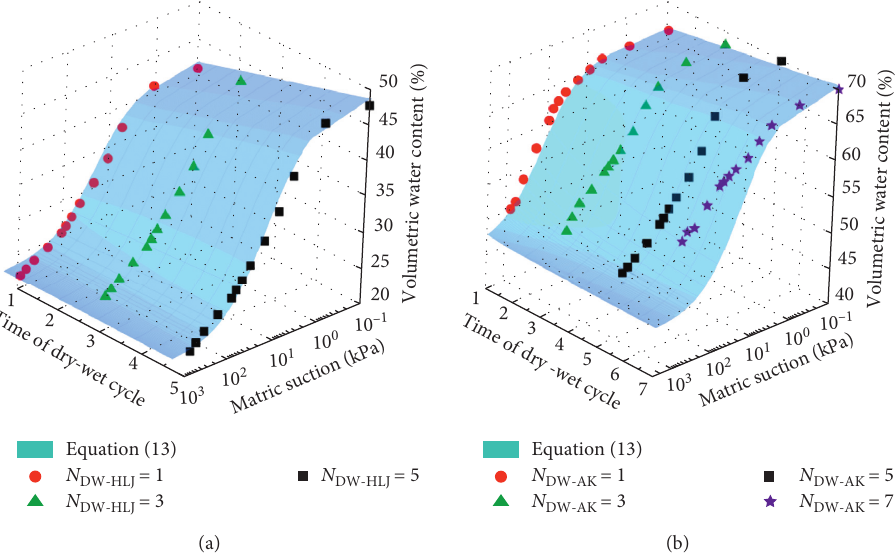
Figure 14: The three-dimensional fitting results of SWCC under different times of dry-wet cycle: (a) HLJ soil and (b) AK soil.